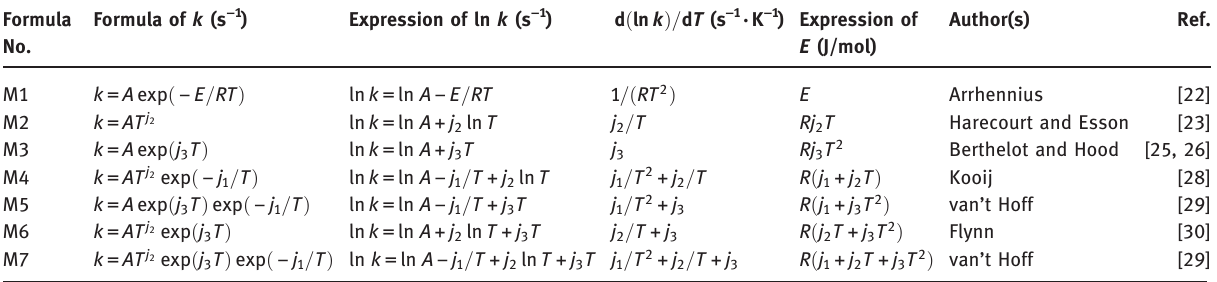
Table 2: Summary of seven collected formulas of crystallization rate constant k from the literature. Formula